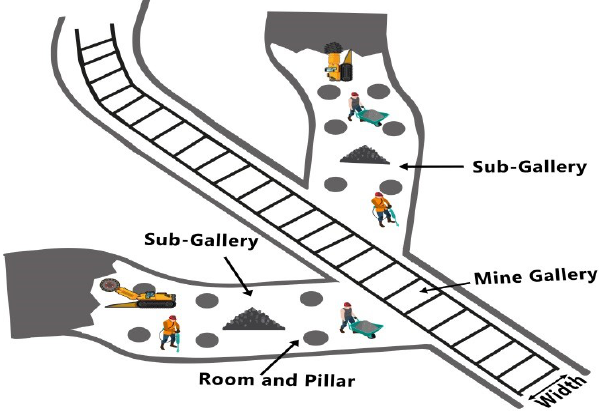
Figure 2. Structural design of coal mine